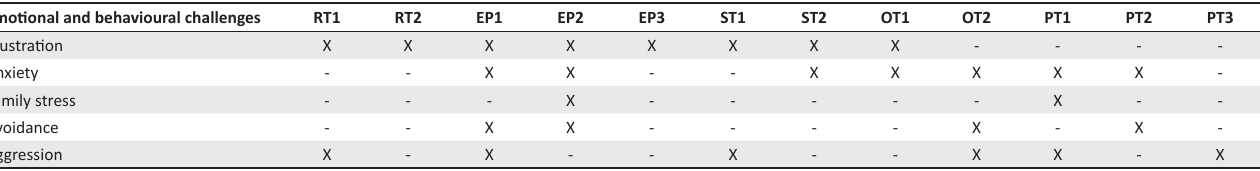
TABLE 3: Emotional and behavioural challenges identified by the participants. Emotional and behavioural